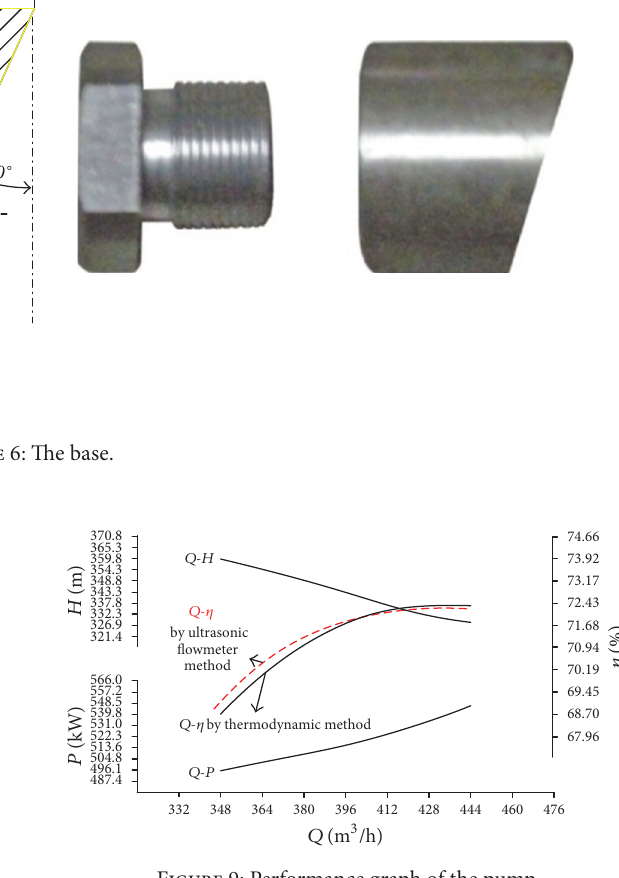
Figure 9: Performance graph of the